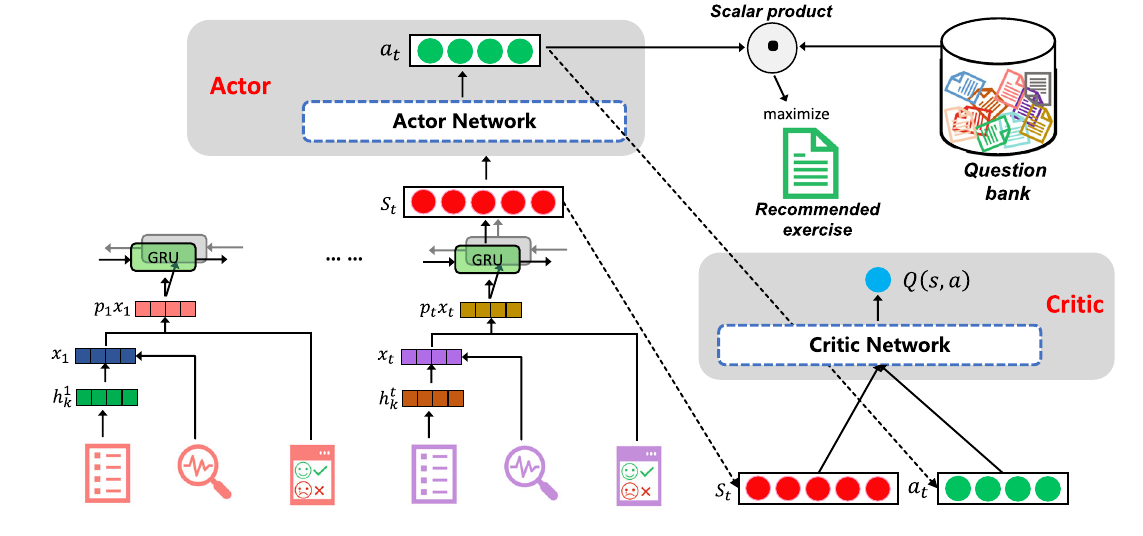
Fig. 4 A single DMoSwR-DRL